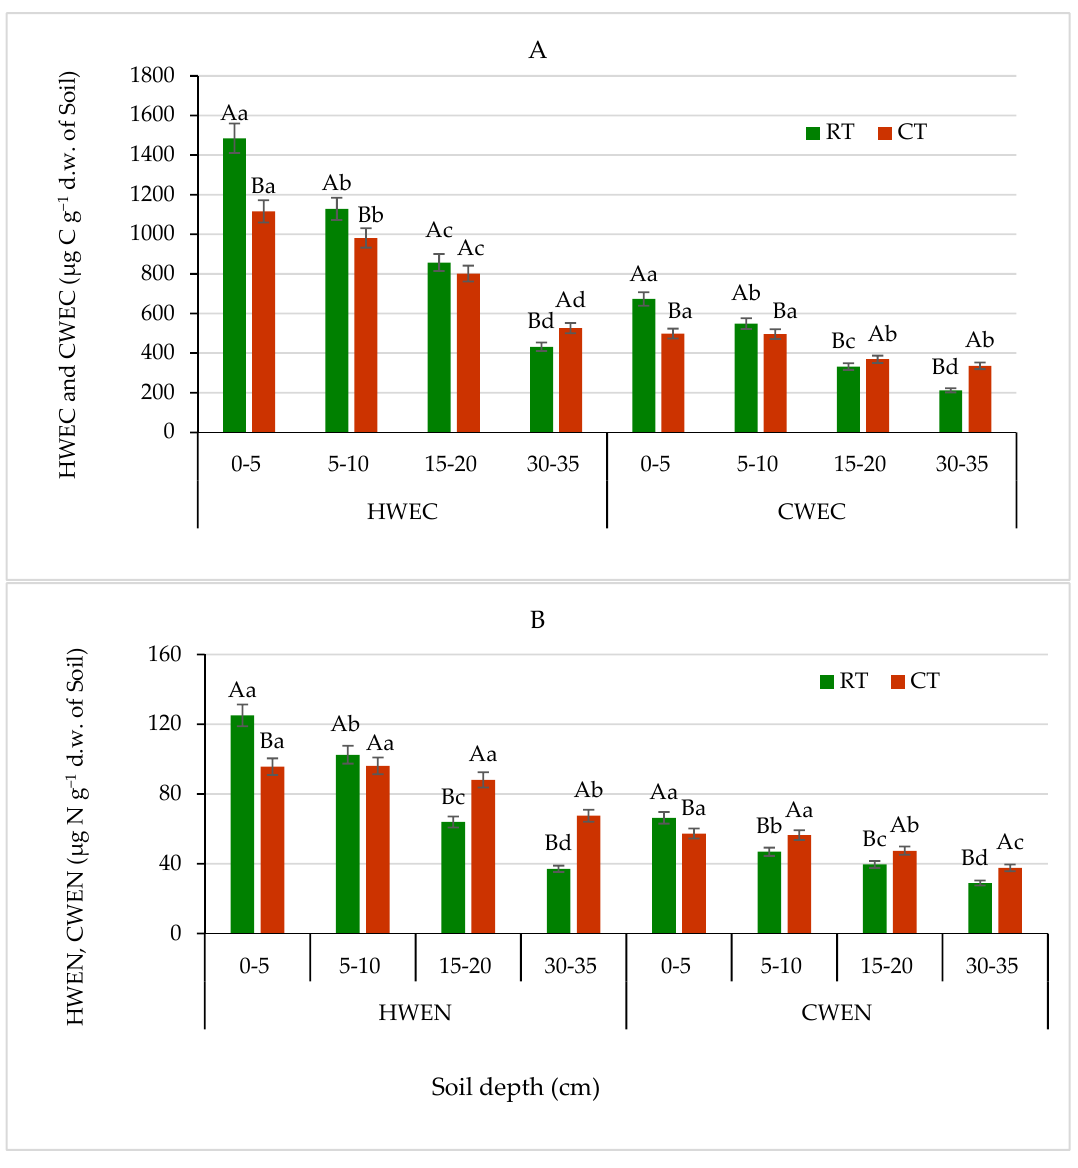
Figure 6. ( A )—Hot-water-extractable carbon (HWEC) and cold-water-extractable carbon (CWEC), ( B )—hot-water-extractable nitrogen (HWEN) and cold-water-extractable nitrogen (CWEN) fractions in soil under different tillage systems in 2018–2020 (expressed as means for the 3 years, n = 12). Different letters represent significant differences ( p ≤ 0.05) across treatments according to Tukey’s HSD test; lowercase letters within the same tillage system indicate significant differences between soil depths; uppercase letters indicate differences between tillage systems. RT—reduced tillage system; CT—conventional tillage system; d.w.—dry weight of soil; n —number of samples. Vertical bars represent standard errors.